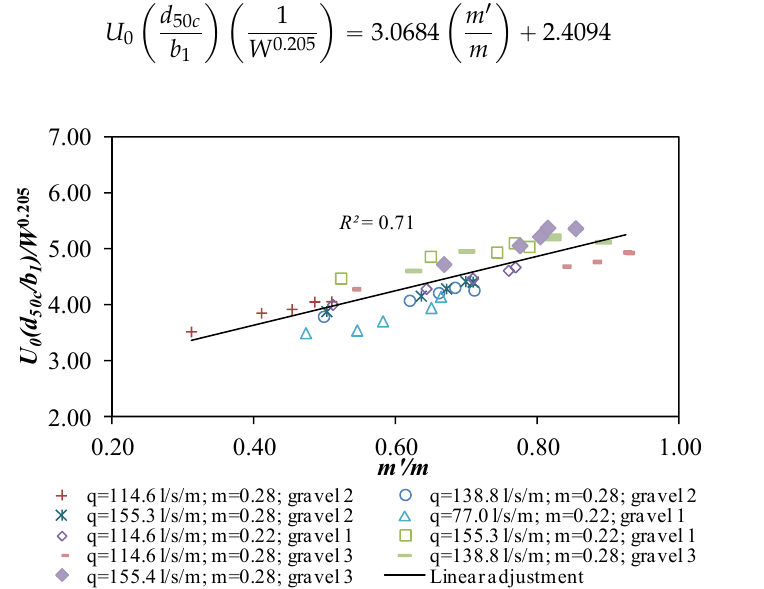
Figure 15. Linear adjustment of the ratio m'/m ratio as a function of the values U 0 , d 50c /b 1 and W.